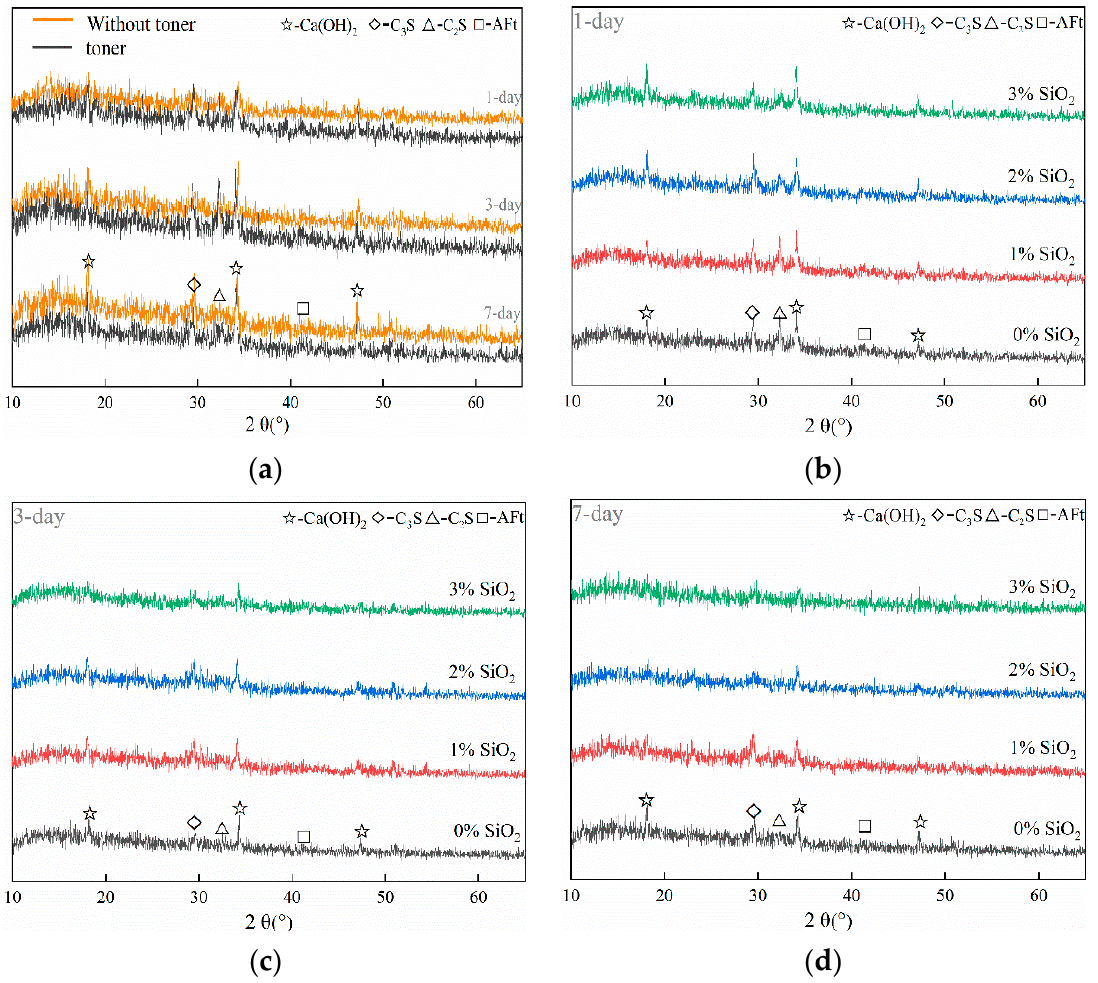
Figure 6. FTIR spectrums. ( a ) Cement grouting materials without the N ‐ S, ( b ) CRTS at 1 ‐ day, ( c ) CRTS at 3 ‐ day, and ( d ) CRTS at 7 ‐ day.